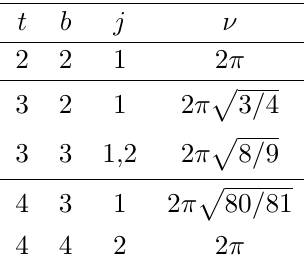
Table 1 . Hagedorn slope for various examples up to t = 4. j is the integer that maximizes (cid:11)